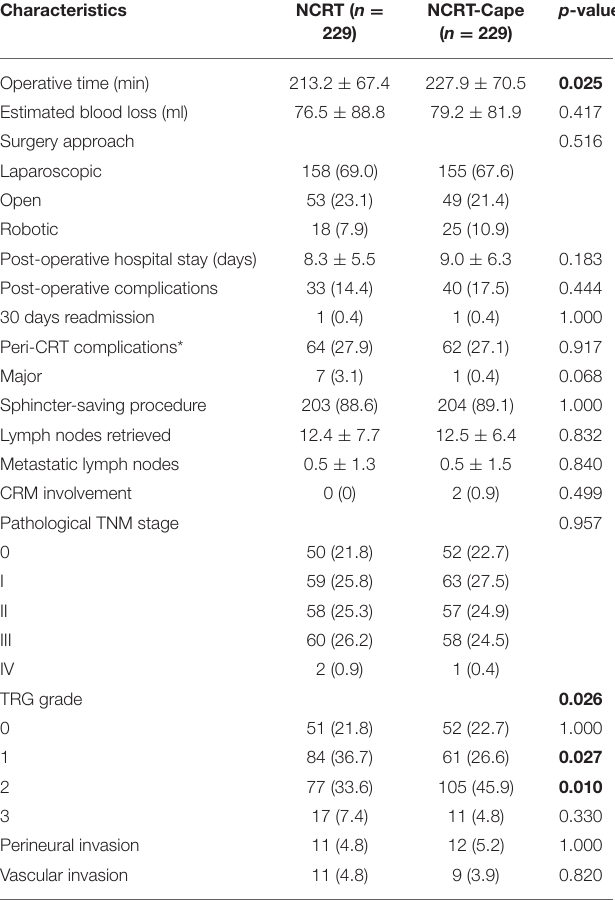
TABLE 2 | Operative and post-operative outcomes in patients with LARC after NCRT.